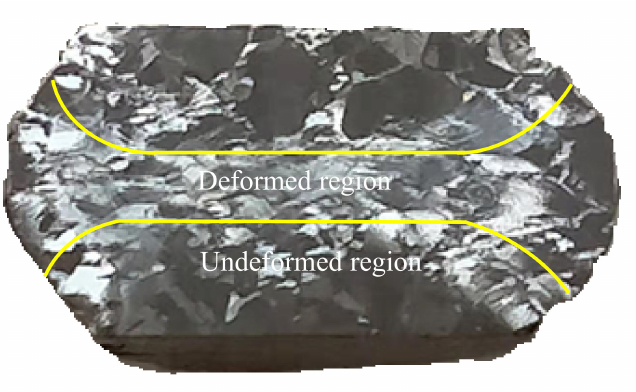
Figure 12. A typical Gleeble compressed sample showing highly deformed